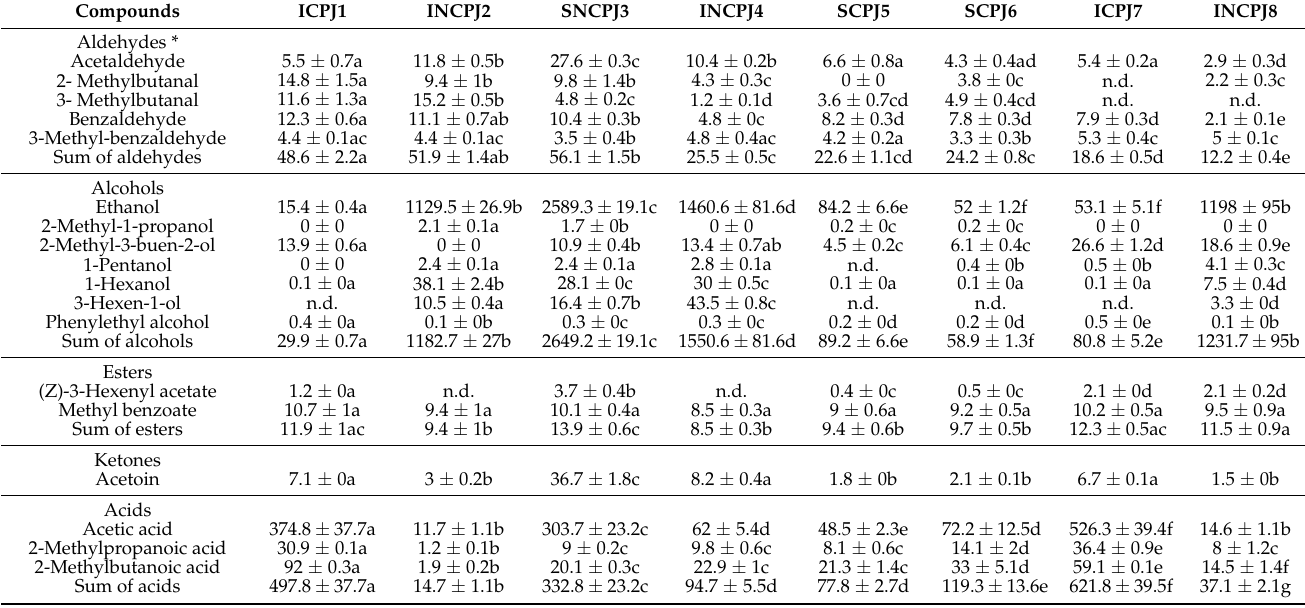
Table 8. Volatile compounds ( µ